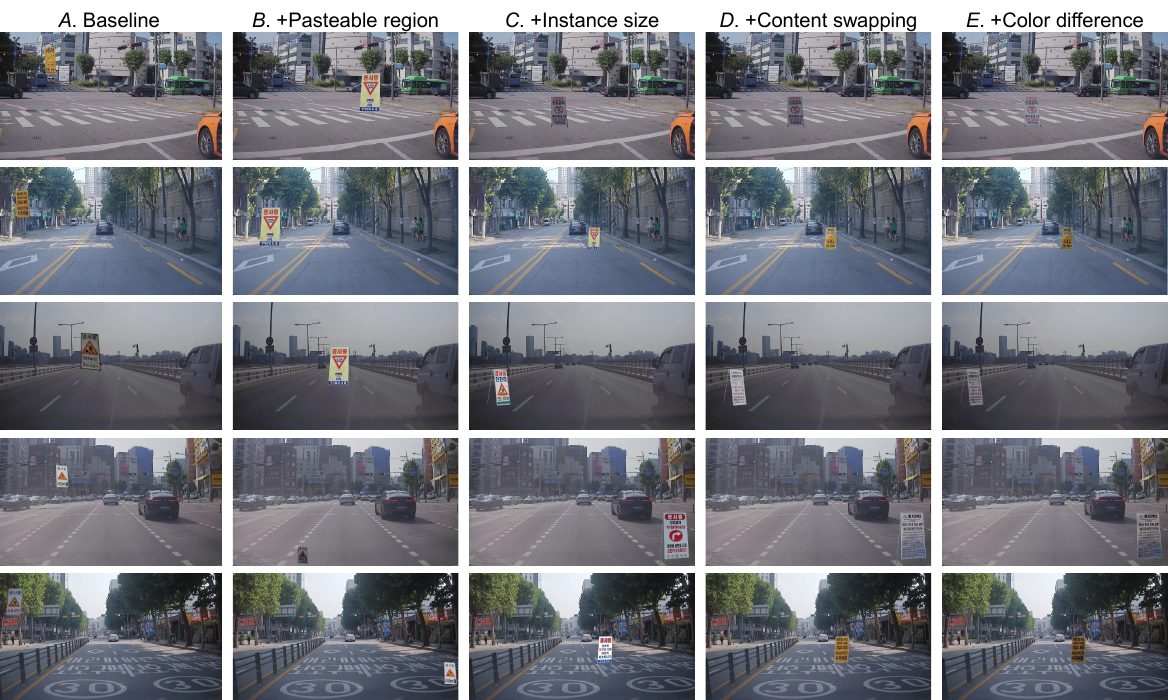
Figure 10. Synthesized training images. For each method, we sampled from the same five back- ground